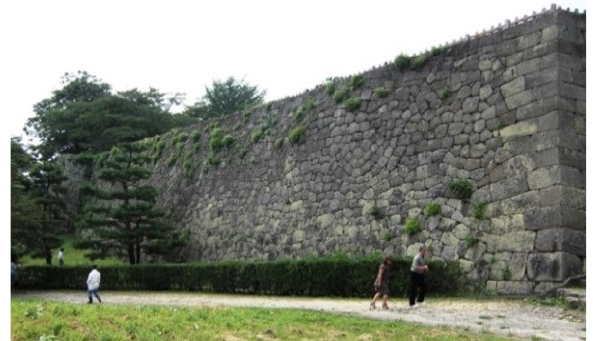
Figure 1. Example of a typical castellated